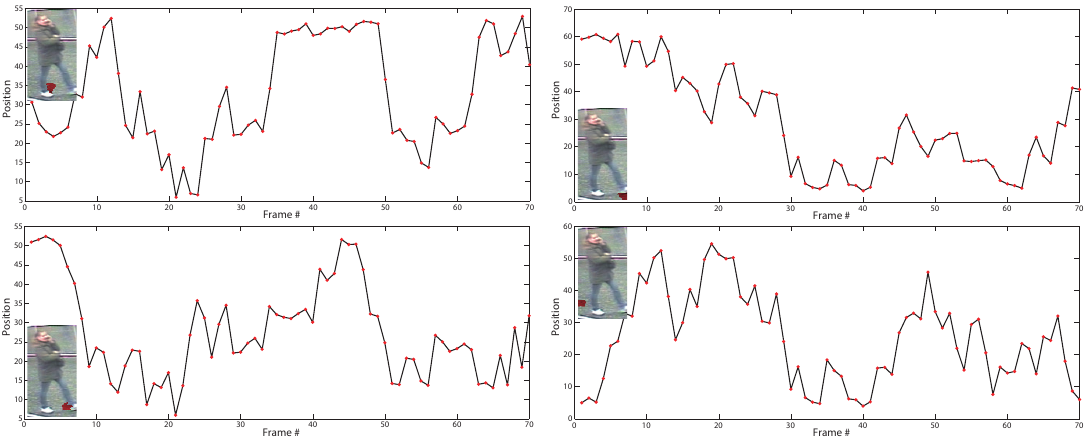
Figure 3. Motion information of four superpixels on the background, from the same sequence in Figure 2. The figure is best viewed in